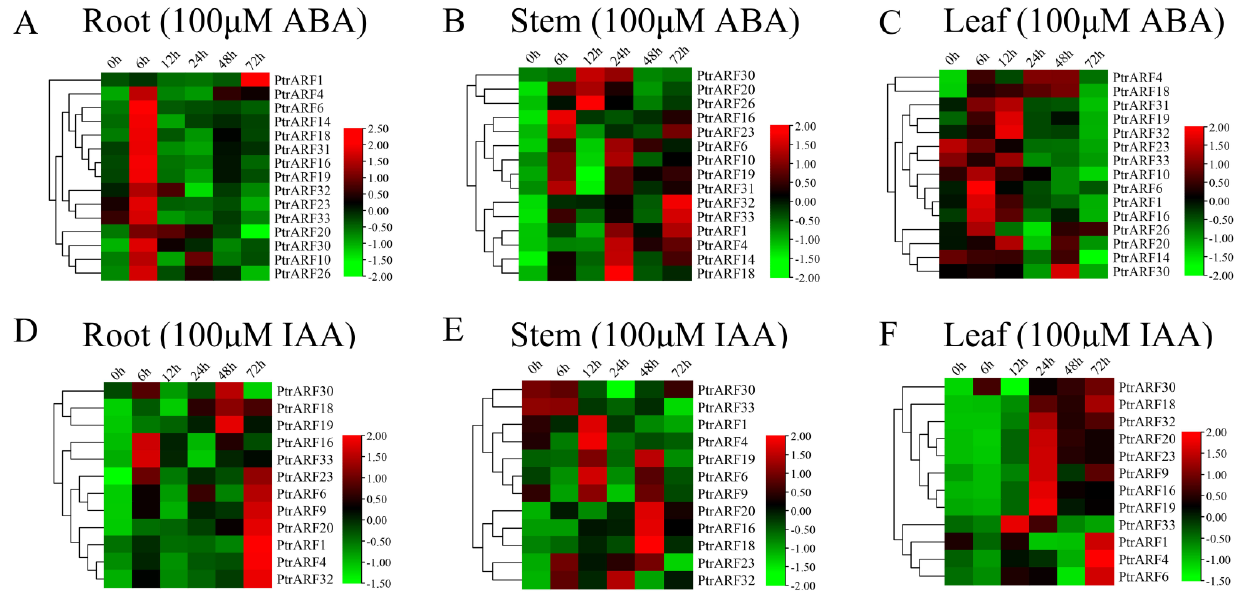
Figure 8. Spatio-temporal expression patterns of PtrARF genes under exogenous ABA and IAA treatment. ( A – C ) Heatmaps of relative gene expression levels treated with 100 µ M ABA. ( D – F ) Heatmaps of relative gene expression levels treated with 100 µ M IAA. The expression levels of each gene were calculated relative to its expression level at 0 h. We standardized each gene in heatmaps.